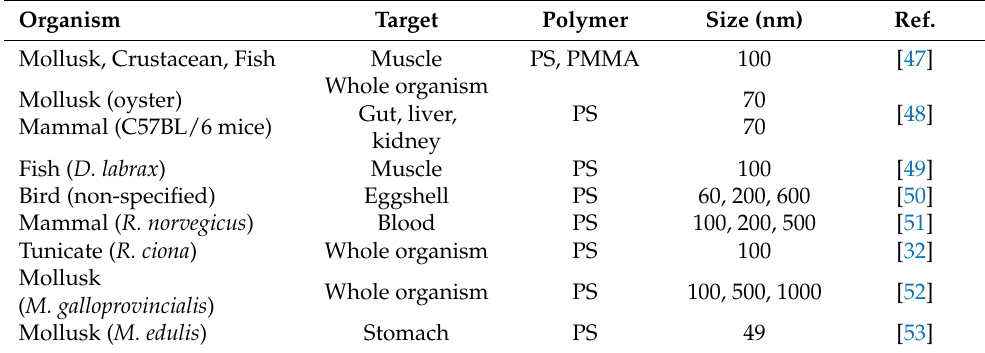
Table 3. List of studies that developed novel methodologies for the detection of NPs in biological